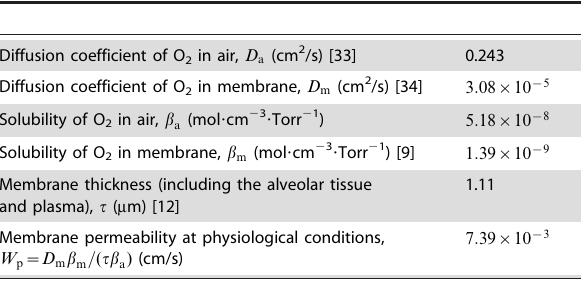
Table 1. Transport parameters to compute O 2 currents at temperature